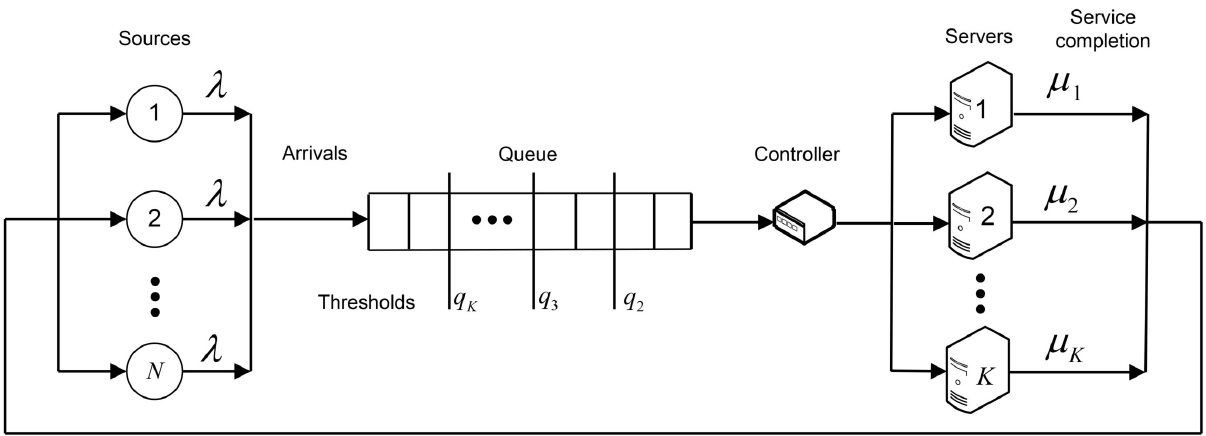
Figure 1. The schema of the finite-source queueing